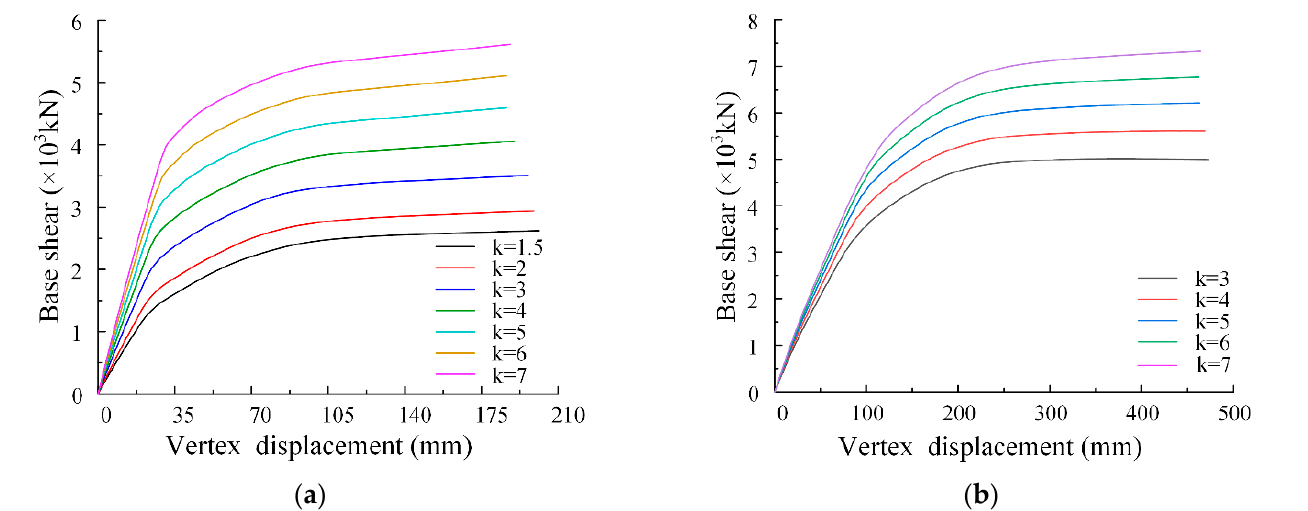
Figure 12. Base shear-vertex displacement curve: ( a ) 4-story PCF-BRB structure and ( b ) 12-story PCF-BRB structure.